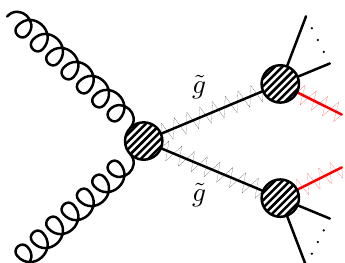
Figure 2. Pair production and decay of gluino continuum at the LHC. The red lines correspond to